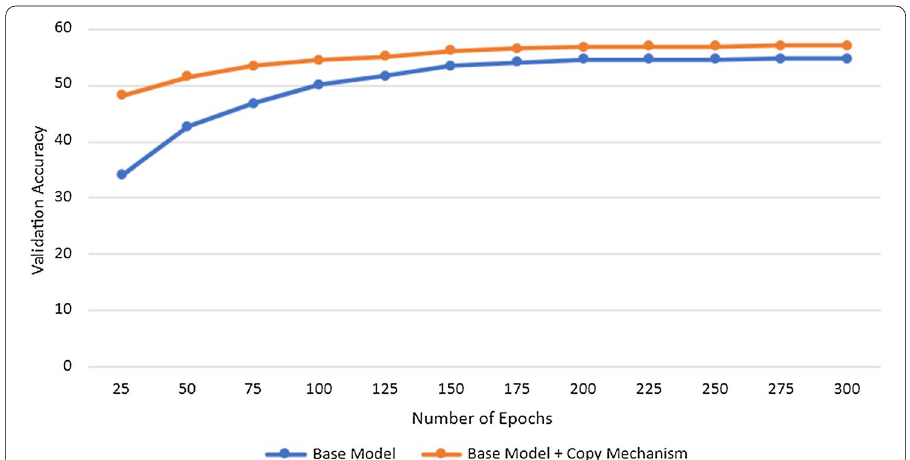
Fig. 7 Results comparison between baseline model and baseline model with copy mechanism for different number of epochs